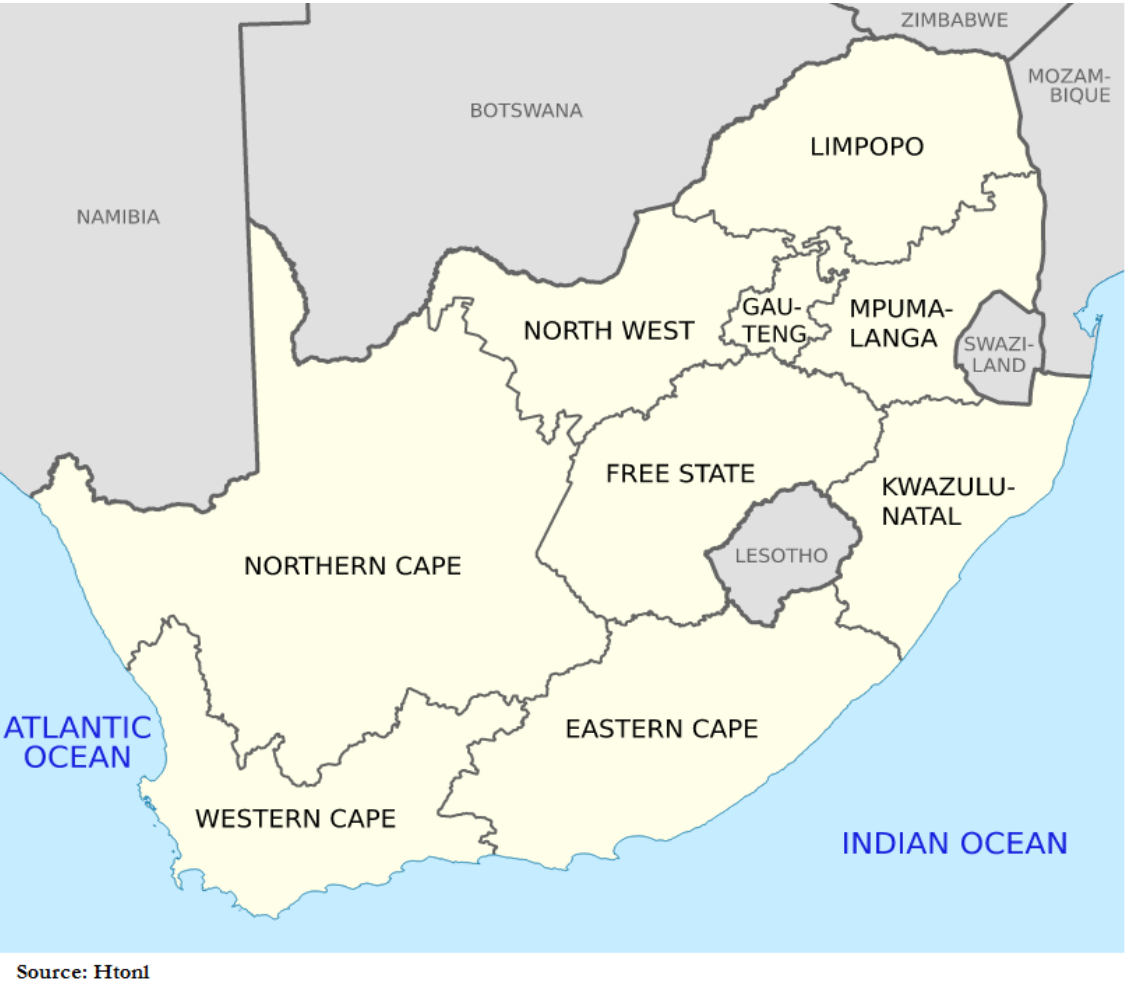
Figure 1: The map of South Africa showing its neighbouring